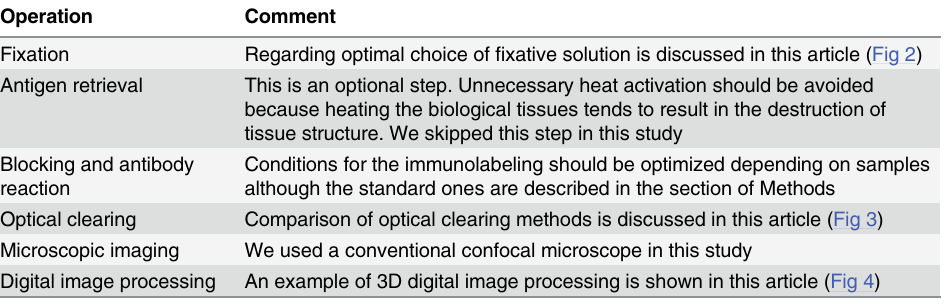
Table 1. A typical protocol for whole-tissue quantification via immunofluorescence in descending